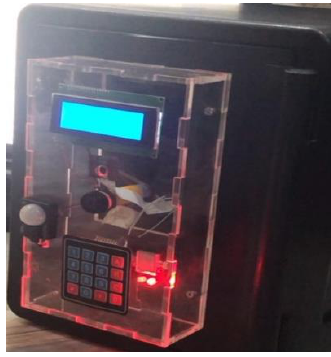
Figure 5. The red color is turned on when an incorrect password is entered.